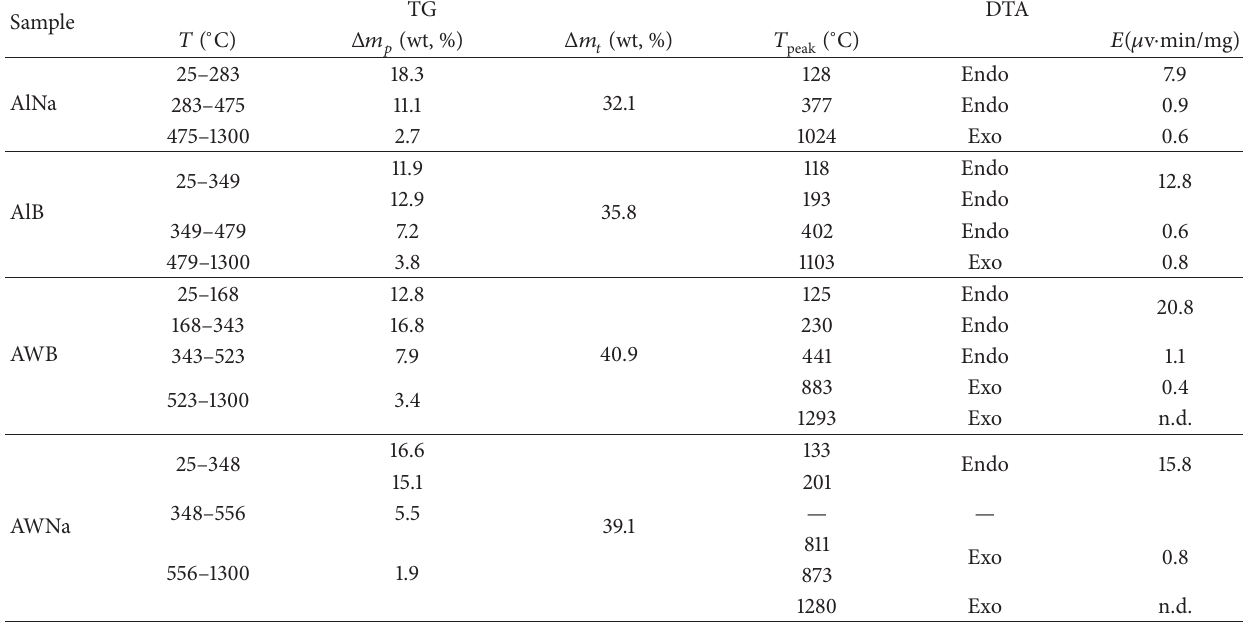
Table 2: Thermal analyses